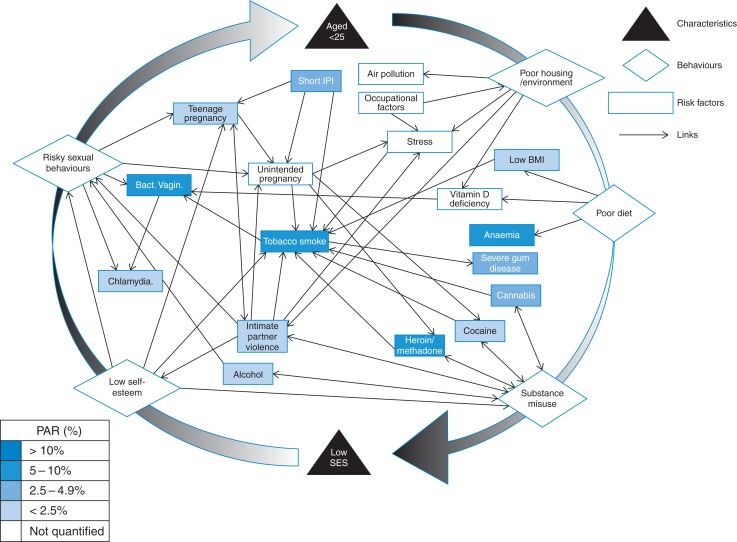
Relationship web between risk factors for LBW.